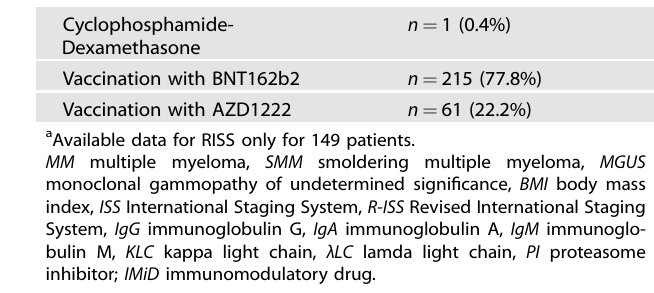
Table 1. Baseline characteristics of patients with